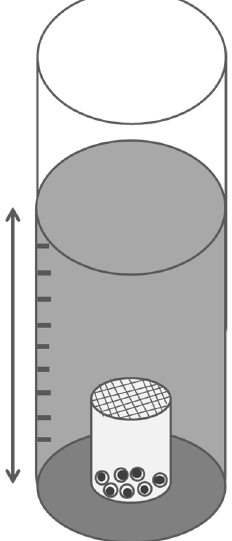
Figure 1. Static hydraulic pressure generated by water column. Zebrafish embryos were main- tained in a small beaker covered by a thin net on the bottom of the glass cylinder. Water level modulates the applied pressure